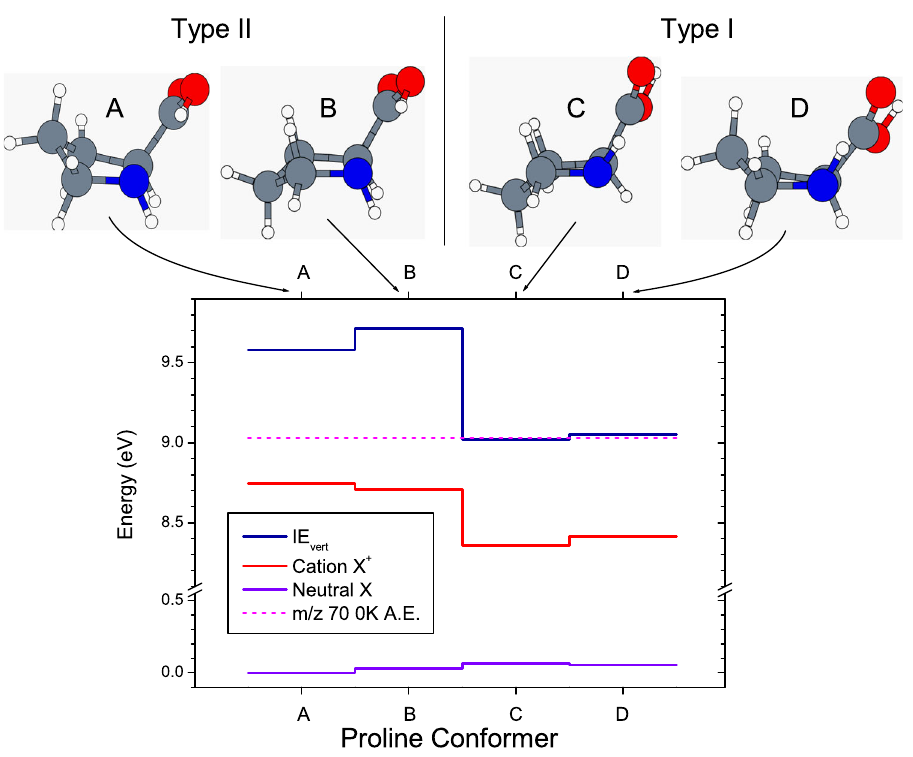
Fig. 1 Calculated proline conformer structure and energetics. The O atoms are colored in red, the N atoms in blue. The blue curve represents the electronic energies of the neutral and the red one the energies of the cation, with the difference being the estimated adiabatic (0 K) ionization energy (see Table 1). The vertical ionization energies (IE vert ) appear as a dark blue curve. Also shown (broken magenta line) is the experimentally estimated 0 K appearance energy of the principal fragment m/z